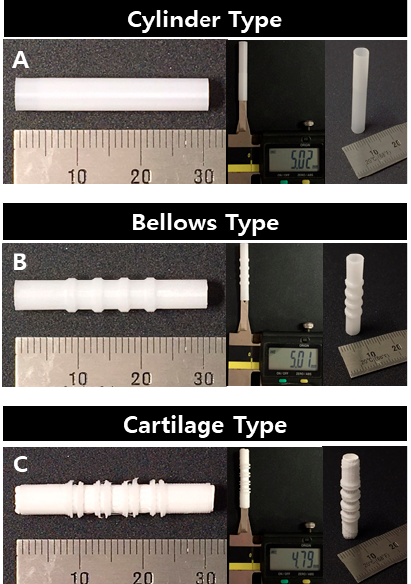
Figure 7. Fabrication results for trachea scaffolds: ( A ) cylinder type, ( B ) bellows type, ( C ) cartilage type.